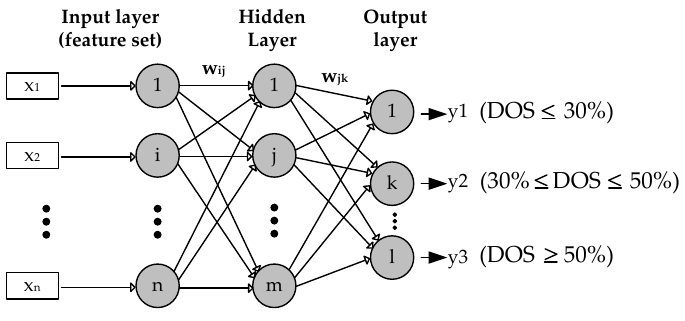
Figure 5. Multilayer Perceptron Network Structure.